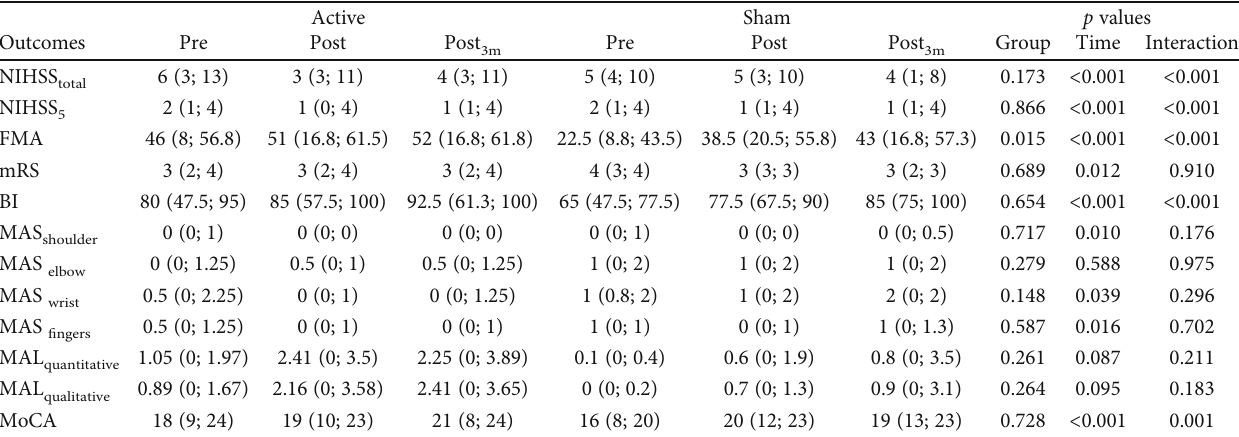
Table 2: Outcomes assessed before the fi rst session of treatment (Pre), after the last session of treatment (Post), and three months later (Post ): intention-to-treat analysis, Generalized Estimating Equation model. Median and interquartile ranges are given. 3m